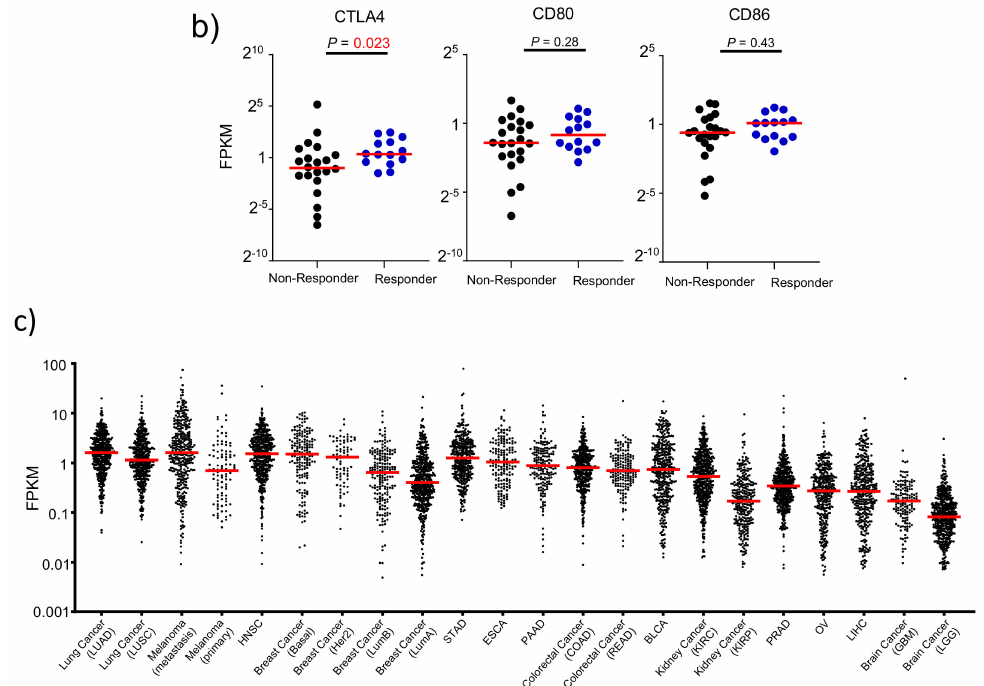
Figure 2. CTLA-4 transcripts associate with therapeutic response to Ipilimumab. ( a ) Volcano plot of mRNA expressions change between anti-CTLA-4 therapy responder and non-responder samples. The x-axis specifies the fold-changes and the y-axis specifies the negative logarithm to the base 10 of the p -values. Grey vertical and horizontal dashed lines reflect the filtering criteria. Red and green dots represent genes expressed at significantly higher ( n = 169) or lower ( n = 178) levels, respectively. ( b ) The distribution plot shows selected gene expression di ff erences. ( c ) Levels of the CTLA 4 transcripts among human cancers. The transcript levels of 7279 cancer samples were depicted individually in dot plots. Median values of each cancer type are indicated in horizontal